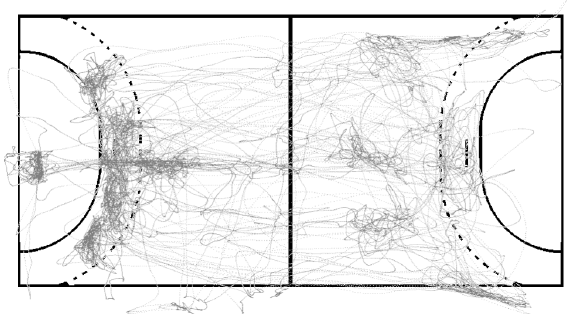
Figure 10. The dataset for the last experiment: the trajectories of 7 handball players are analyzed. Figure 8. The data basis for the football experiment: the trajectories for the players during the full match are encoded by colors.